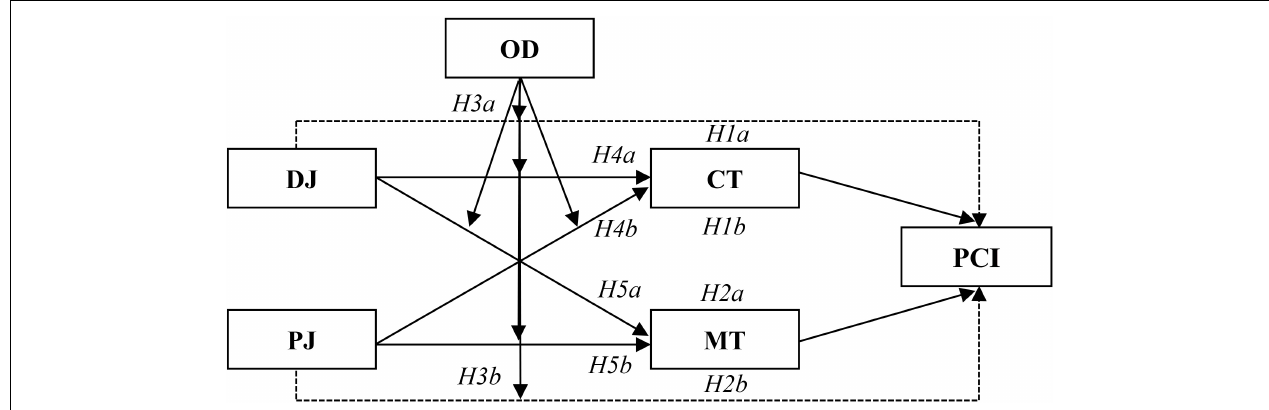
FIGURE 1 | Research model and hypotheses. DJ, distributive justice; PJ, procedural justice; CT, competence-based trust; MT, motive-based trust; PCI, public cooperation intention; OD, outcome